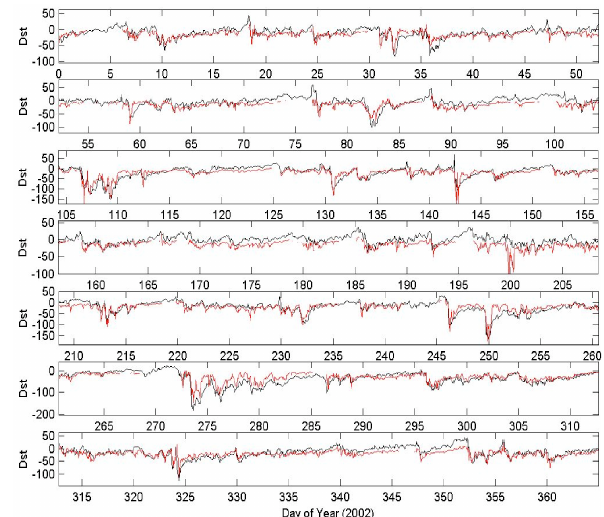
Figure 8 Fig. 8. The K p index values as a function of time in the year 2002 are specified by their corresponding driver states, in accordance with the magnetospheric state prescription of Eqs. (5) and (6). Mag- netospheric states are specified by the driver and response param- eter data obtained in 1970–2001, with V sw (E0), B z (E1), P sw (E0), and B tot (E0) having been localized. The estimation (RMS) error is ± 0.795 [in K p unit]; consistent with the global deviation shown in Fig. 6a and correlation factor with the actual data is 0.801. Black line is the actual observed K p index and red line is the estimated K p index. The gaps in the red line indicate periods of no solar wind data.